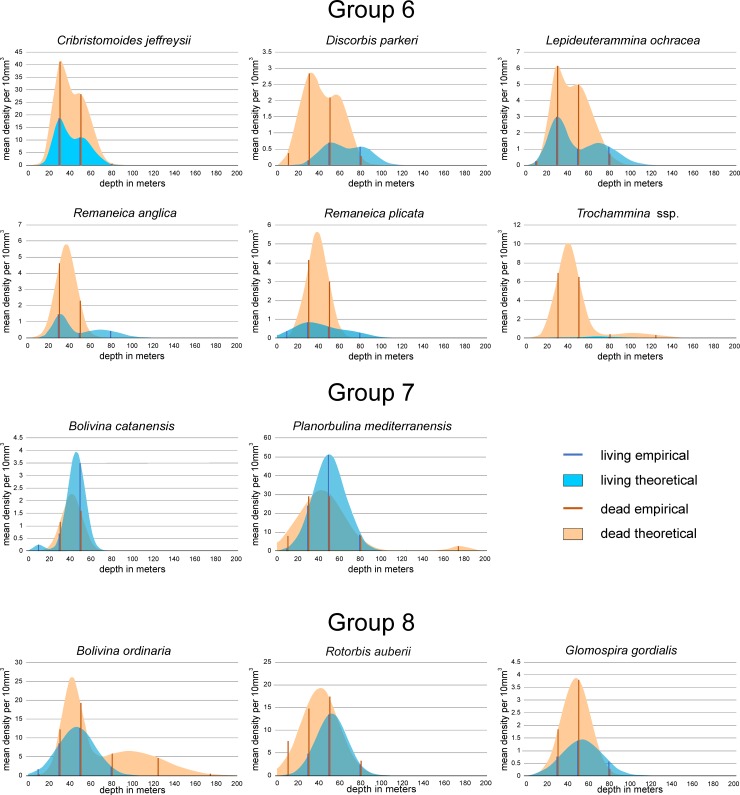
Depth frequencies of living and dead individuals for species of groups 6 to 8 according to UPGMA cluster analysis.Groups are positioned in the CCA of Fig 12.